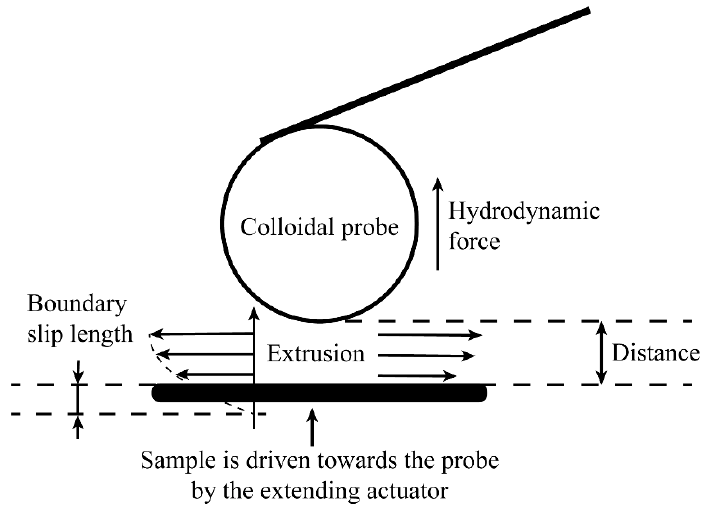
Figure 1. AFM ( Atomic force microscope ) contact mode measurement model and principle. Figure 1. AFM (Atomic force microscope) contact mode measurement model and